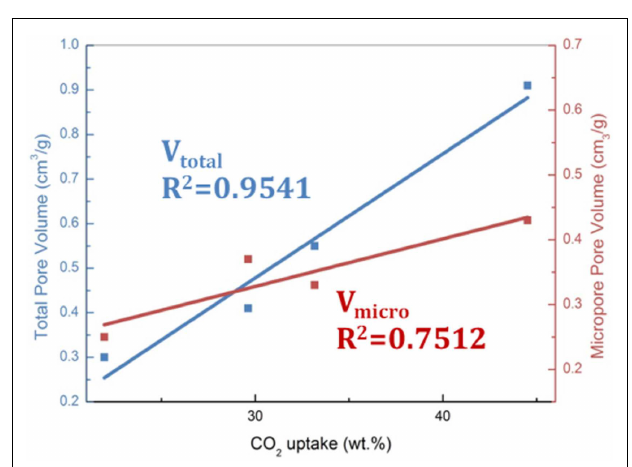
FIGURE 4 |The linearship between high-pressure CO 2 adsorption capacities (30°C, 40bar) and porosity, reproduced from Sun et al. (2013) .